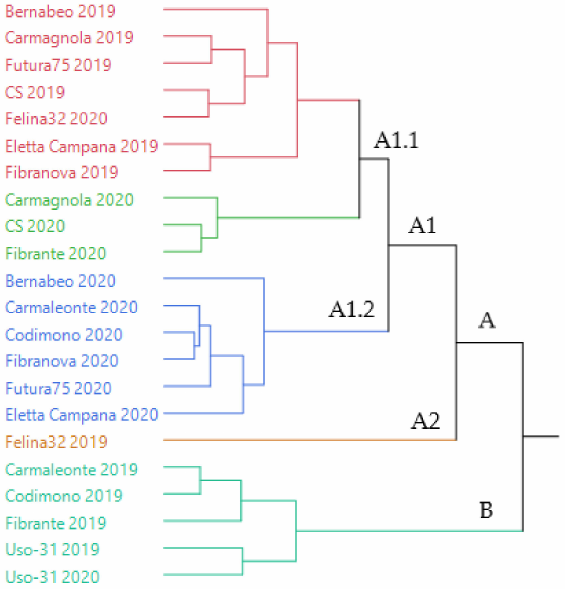
Figure 1. Dendrogram obtained with the hierarchical cluster analysis (HCA) performed on the complete composition of the essential oils extracted from all the hemp samples.